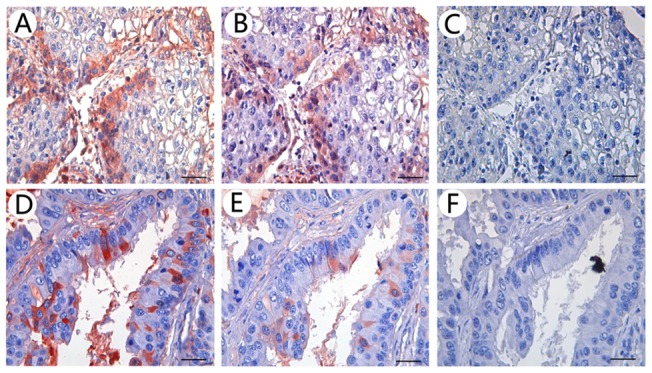
Igγ Antibody preabsorption tests in LSCC and LAC.
A–C, the mouse anti-human Igγ monoclonal antibody: pure human IgG  = 1∶1, 1∶5, and 1∶10 in LSCC sections. D–F, the similar gradient ratio of Igγ: pure human IgG in LAC sections. With the increase of antigen concentration (pure human IgG), the positive IgG signal was weakened. Bar: 20 µm.